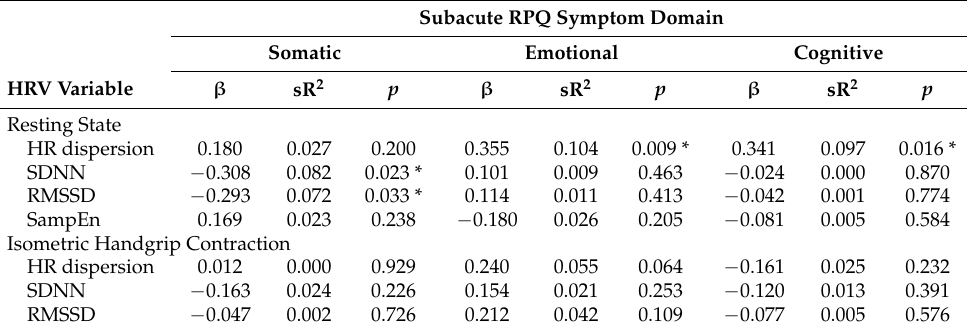
Table 4. Multivariate regression analyses for the Rivermead Post-Concussion Symptom Question- naire (RPQ) a